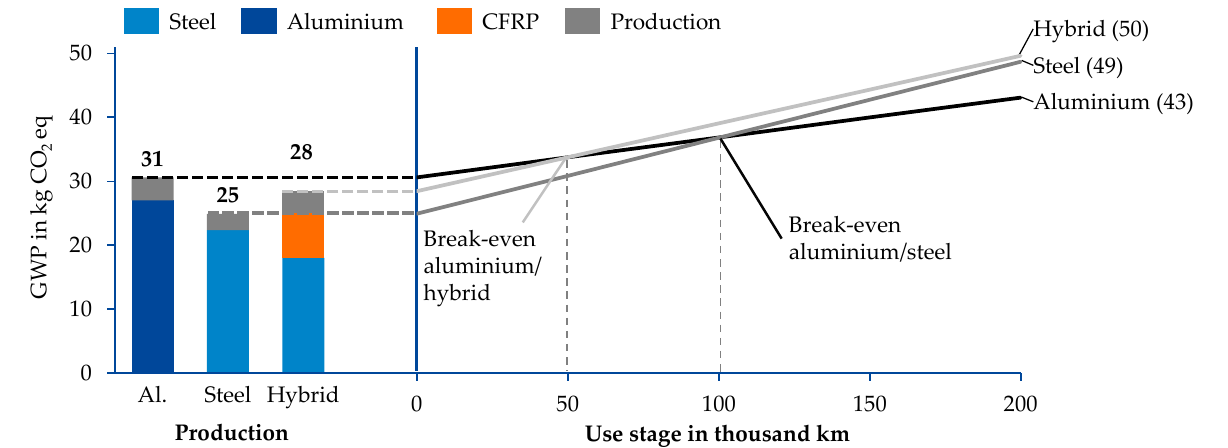
Figure 4. Results of the initial LCA for the production and use stage of the three CMS design alternatives, showing favourable designs in each life cycle stage and possible break-even points.